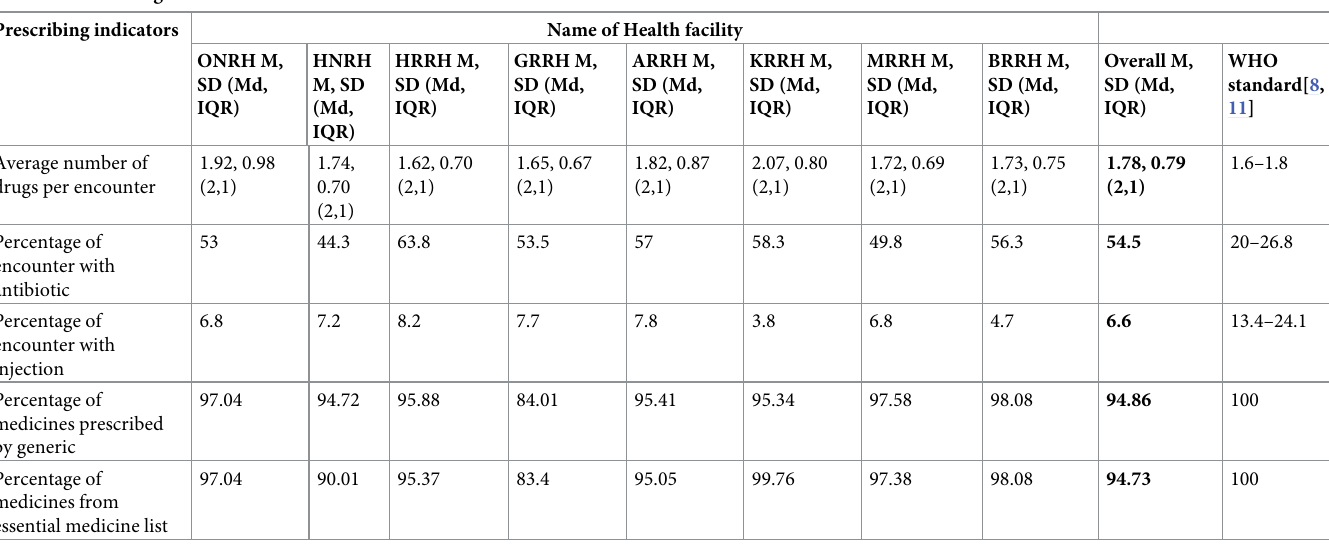
Table 2. Prescribing indicators vis- à -vis WHO core